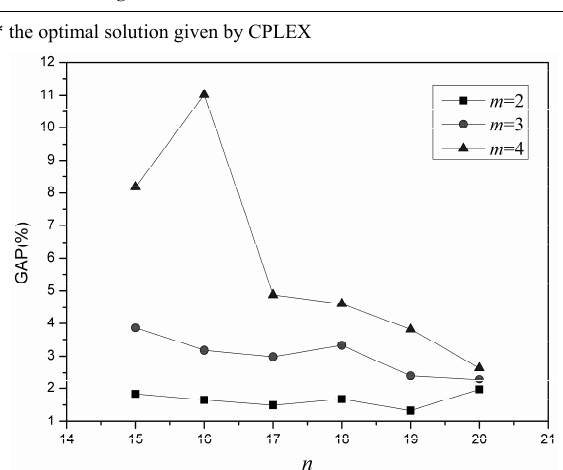
Fig. 12. Comparison of GAP between different numbers of